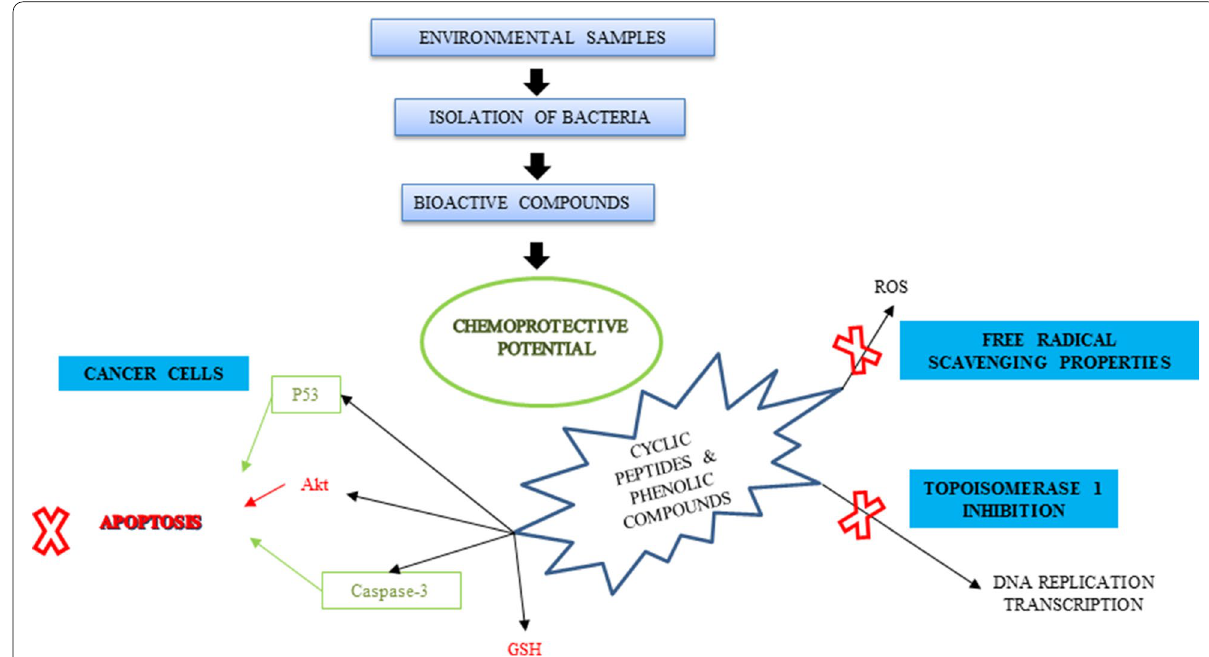
Fig. 4 Anti-cancer potential of bioactive compounds from marine